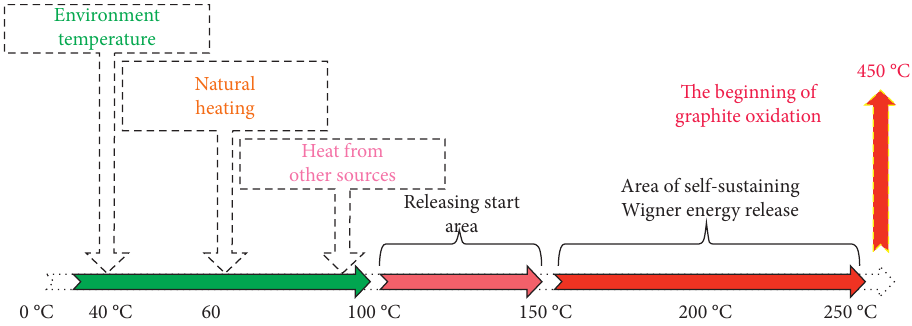
Figure 6: Schematic diagram of the start of heating of graphite radioactive waste in the storage.